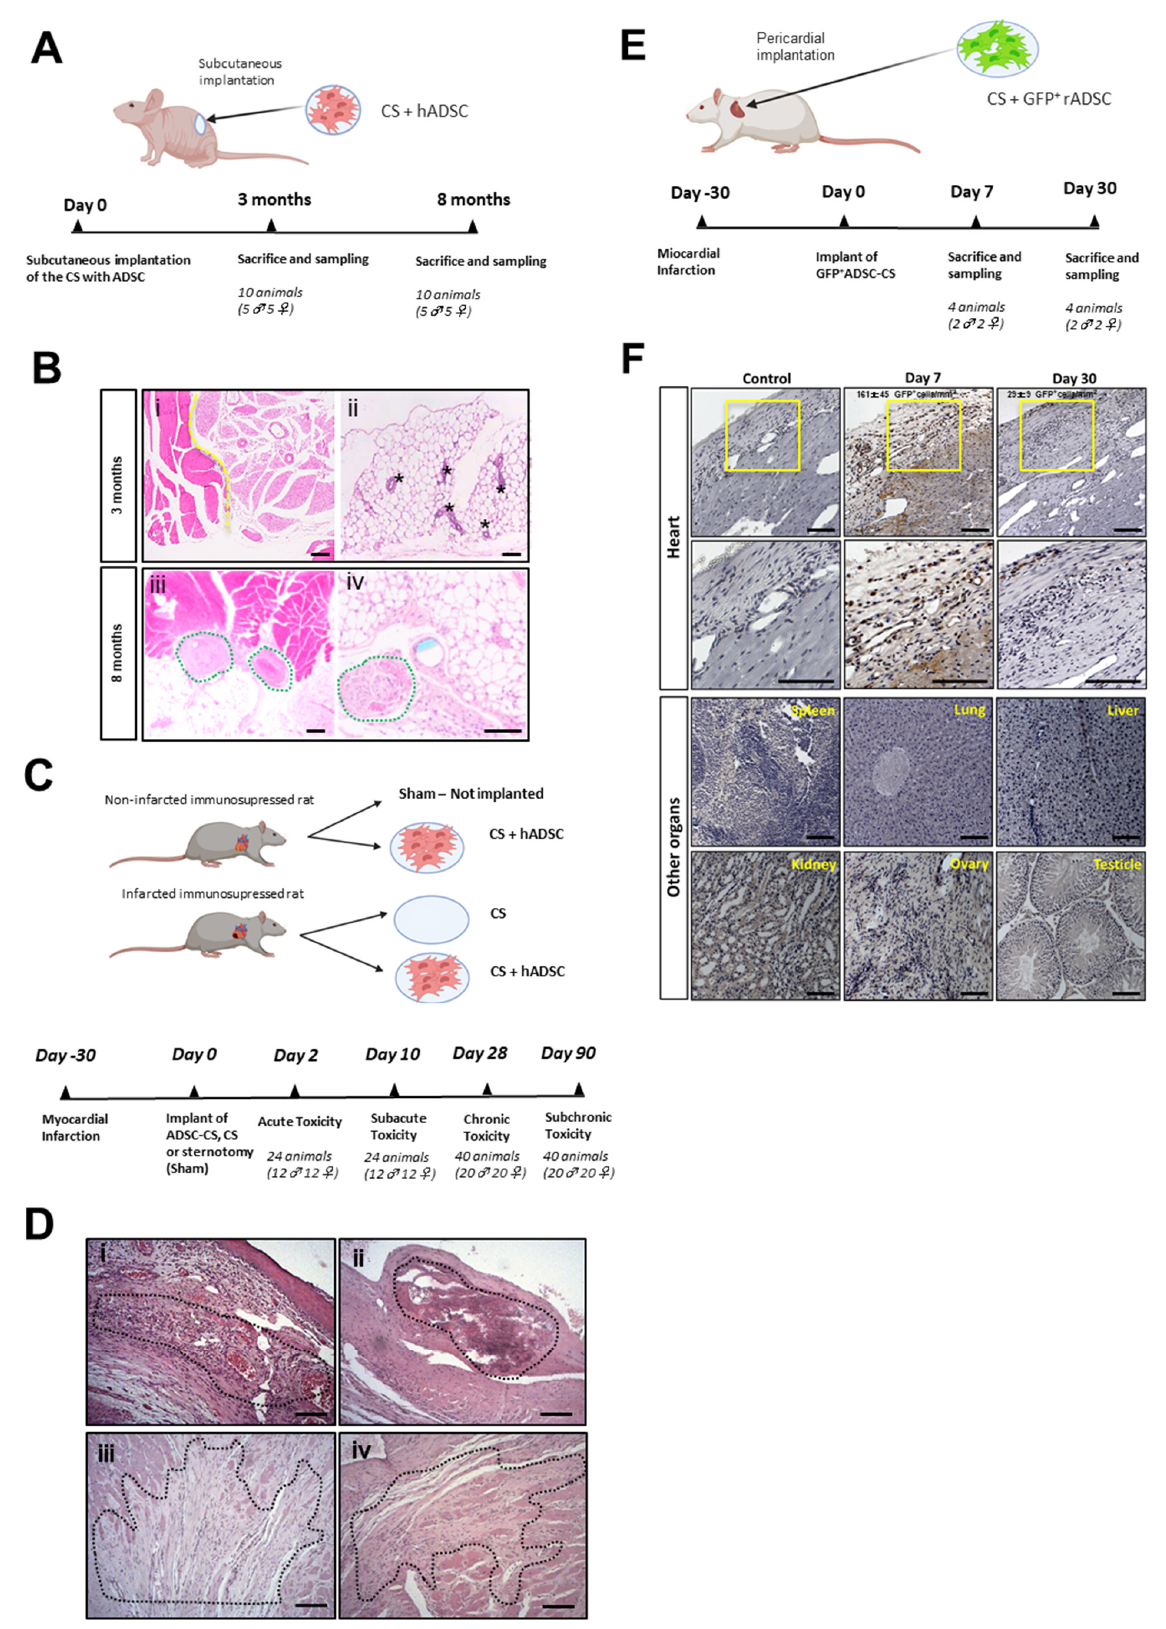
Figure 1. Safety analysis of ADSC-CS in rodent models. ( A ) Tumorigenicity study of the immunosuppressed mice subcutaneously implanted with human ADSC-CS. ( B ) Anatomopathological analysis of the mouse muscle tissues 3- and 8-months post-implantation.